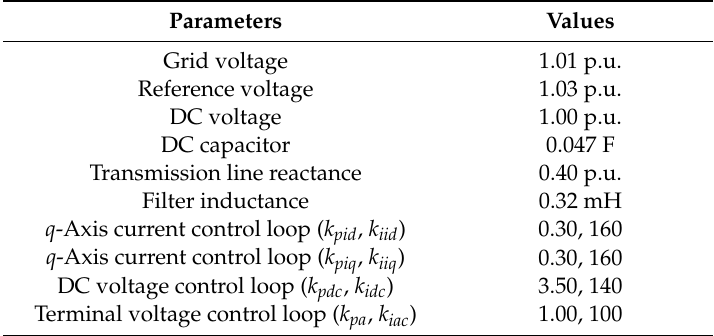
Table 1. GVSC Table 1. GVSC parameters.